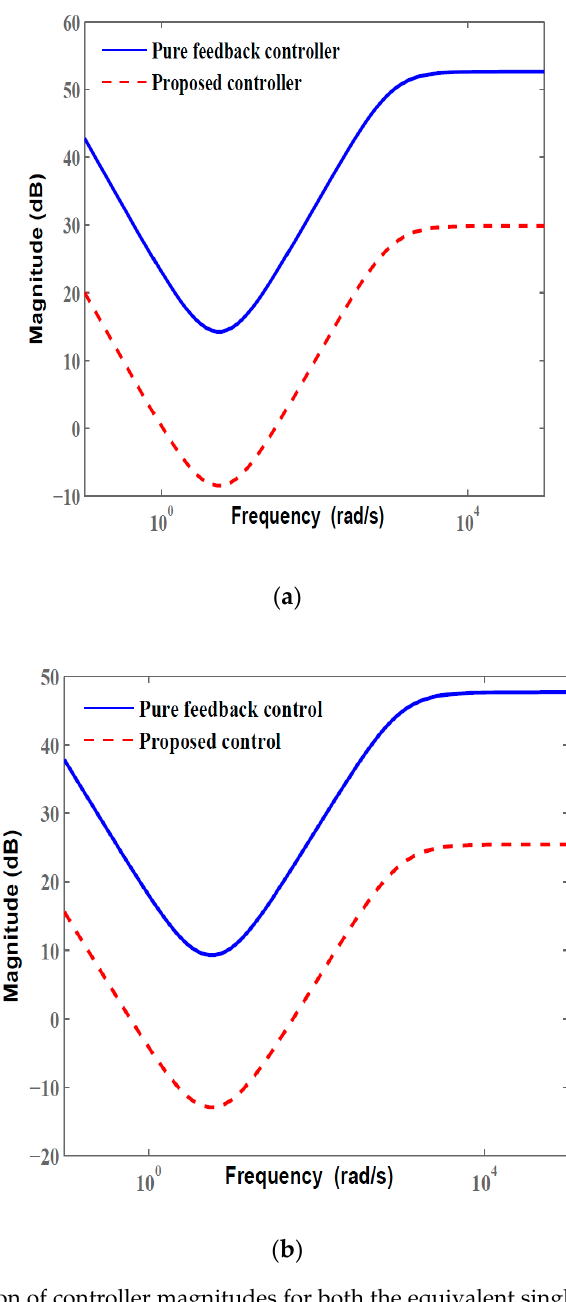
Figure 11. Comparison of controller magnitudes for both the equivalent single-input single-output (SISO) loops; ( a ) channel-11 and ( b ) channel-22.